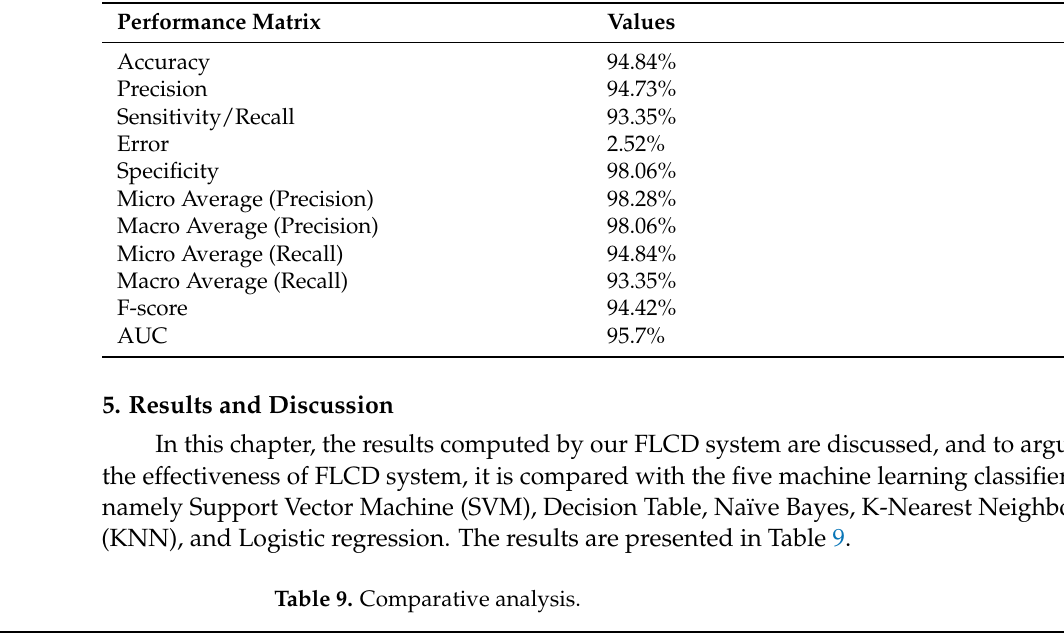
Table 8. The performance matrix of the proposed model.